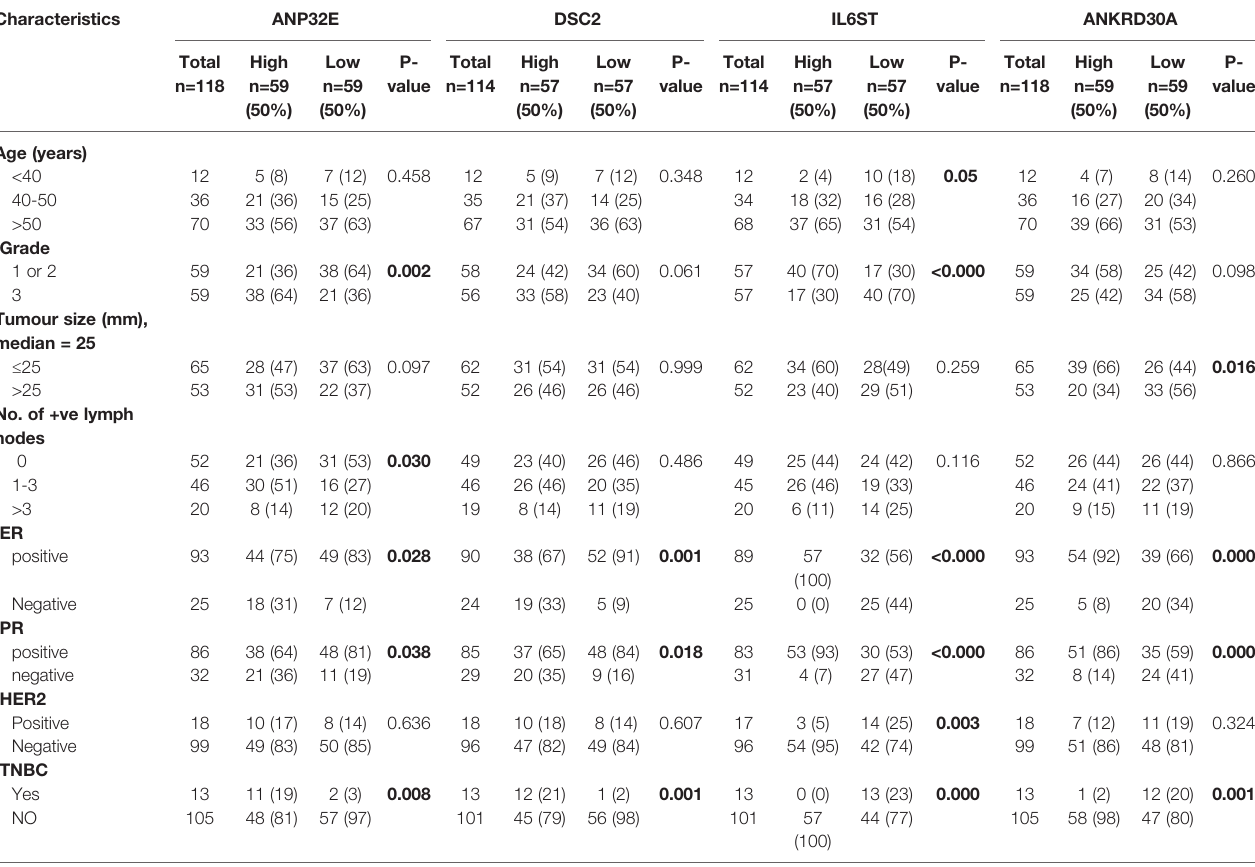
TABLE 4 | Association of ANP32E, DSC2, IL6ST and ANKRD30A mRNA expression with clinicopathological features in breast cancer cases from the second cohort.